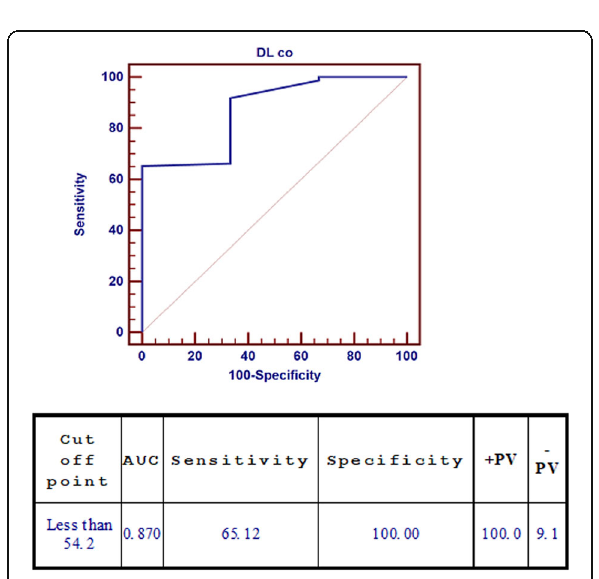
Fig. 2 ROC curve and coordinates for the best cutoff DLCO-SB value to predict ground-glass opacity. ROC, receiver operating characteristic; AUC, area under the